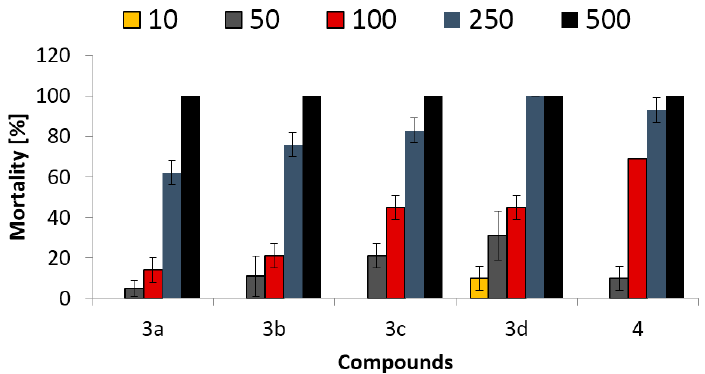
Figure 2. The mortality (%) of Heterocypris incongruens living in soil contaminated with pyrene-derived aminophosphonates 3a – d and 4 at concentrations: 10, 50, 100 and 500 mg/kg of soil dry weight. Error bars represent standard deviation error (SD, n = 6 determinations).